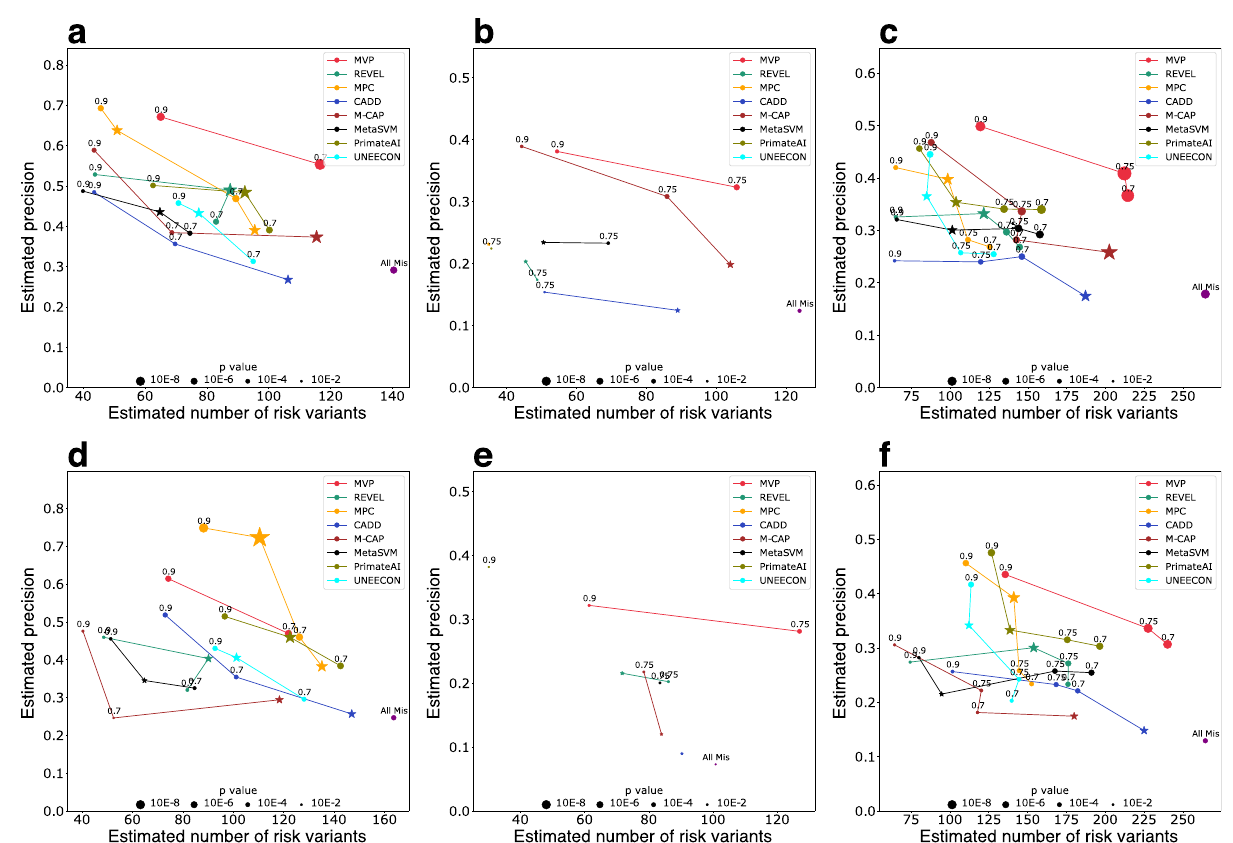
Fig. 4 Comparison of MVP and previously published methods using de novo missense mutations from CHD and ASD studies by precision-recall-proxy curves. Numbers on each point indicate rank percentile thresholds, star points indicate thresholds recommended by publications. The positions of “ All Mis ” points are estimated from all missense variants in the gene set without using any pathogenicity prediction method. The point size is proportional to – log ( p -value). P -value is calculated by two-sided binomial test, only points with p value less than 0.05 are shown. a – c Performance in CHD DNMs in constrained genes, non-constrained genes, and all genes, respectively. d – f Performance in ASD DNMs in constrained genes, non-constrained genes, and all genes,